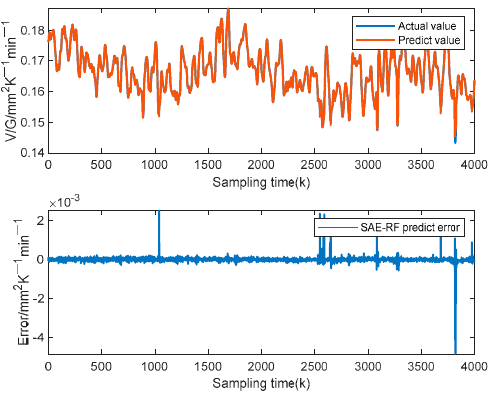
Figure 8. Prediction results of the proposed SAE-RF on the test sets.